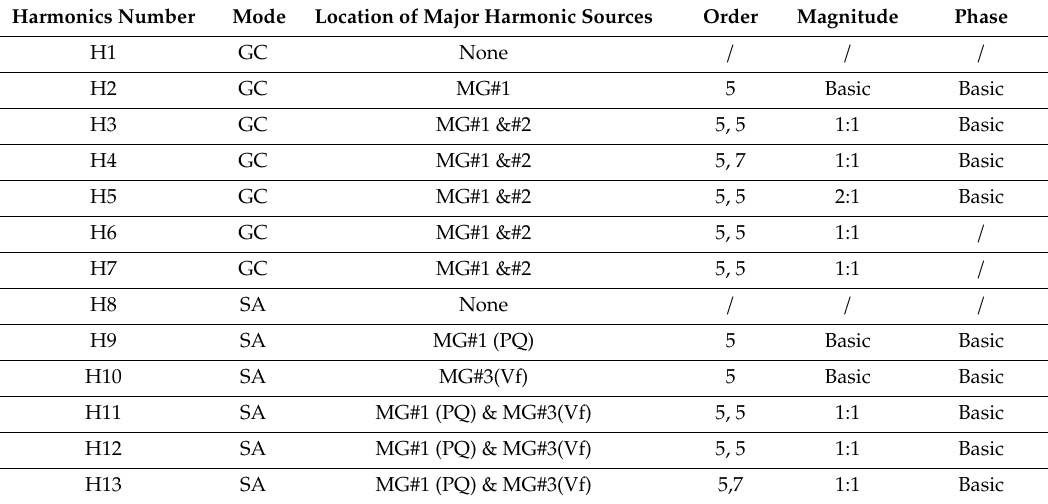
Table 1. Typical simulation scenarios with harmonic